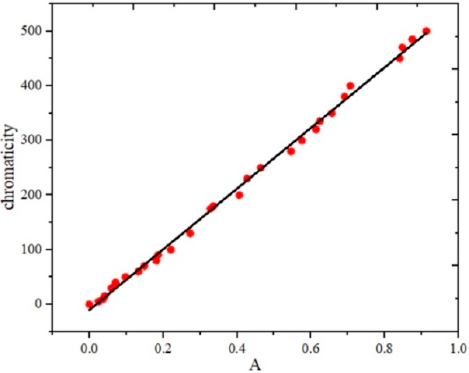
Figure 9. Fitting curves of absorption and chromaticity.